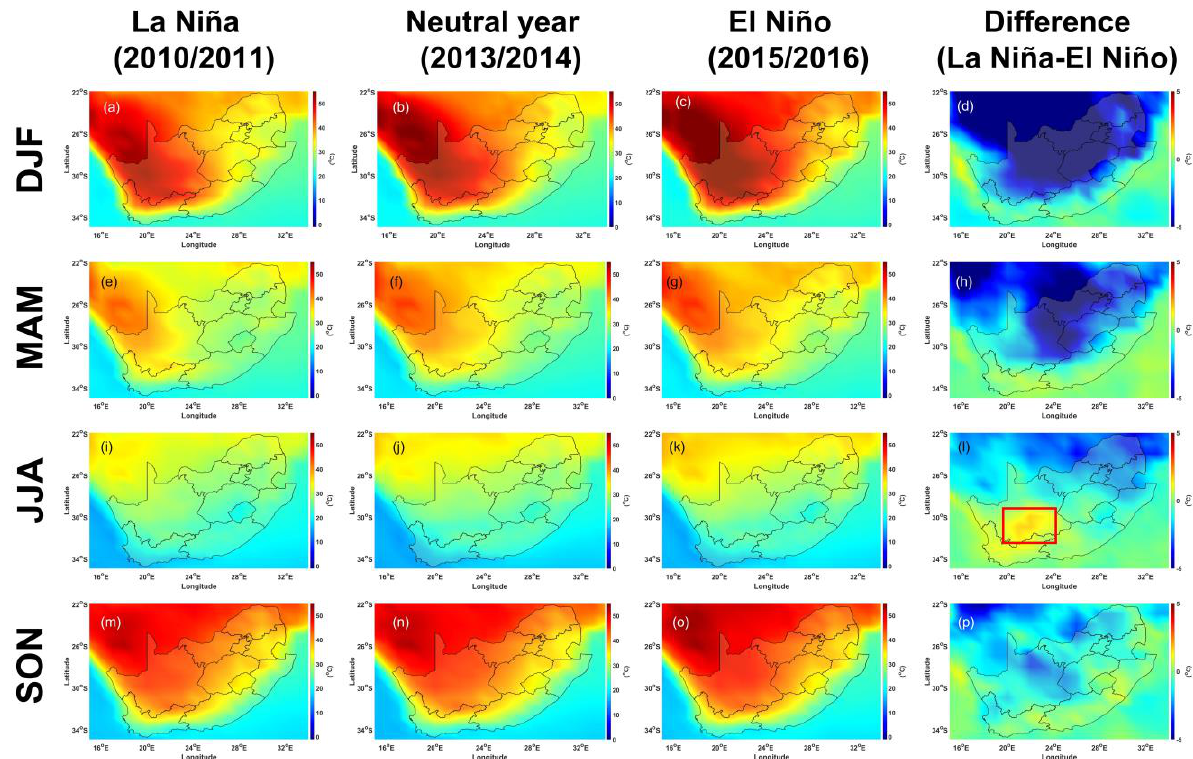
Figure 4. Seasonal mean spatial distribution of temperature during La Niña ( a , e , i , m ), neutral year ( b , f , j , n ) and El Niño periods ( c , g , k , o ) and the difference between the two extremes ( d , h , l , p ).